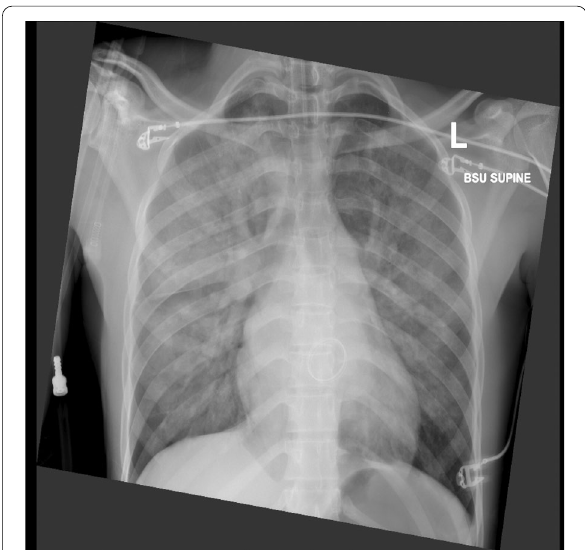
Fig. 1 Chest radiograph showing pulmonary oedema